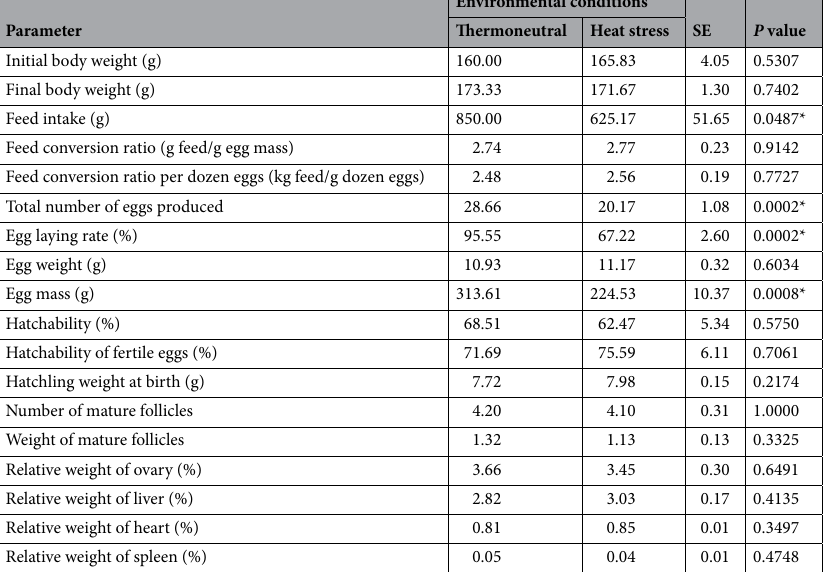
Table 1. As expected, mothers exposed to heat stress had a lower laying rate (about 28% lower) and egg mass than mothers under thermoneutral conditions ( P < 0.05). However, ambient temperature did not affect egg weight,